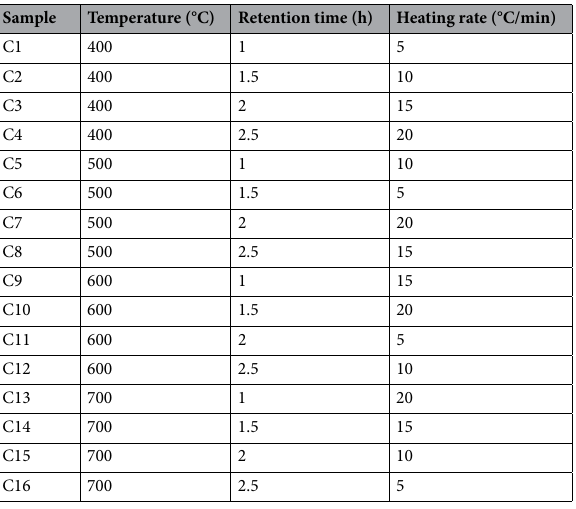
Table 1. Orthogonal experimental